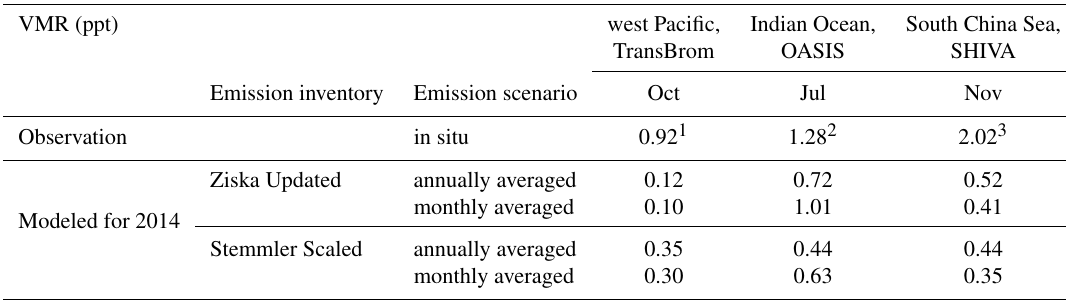
Table 3. Mean bromoform volume mixing ratios (VMRs, in ppt) observed during the research cruises and modeled with FLEXPART at 100m height for the same location and month as the observation, but for the year 2014. VMR (ppt) west Pacific, Indian Ocean, South China Sea, TransBrom OASIS SHIVA Emission inventory Emission scenario Oct Jul Nov Observation in situ 0.92 1 1.28 2 2.02 3 Ziska Updated annually averaged 0.12 0.72 0.52 monthly averaged 0.10 1.01 0.41 Modeled for 2014 Stemmler Scaled annually averaged 0.35 0.44 0.44 monthly averaged 0.30 0.63 0.35